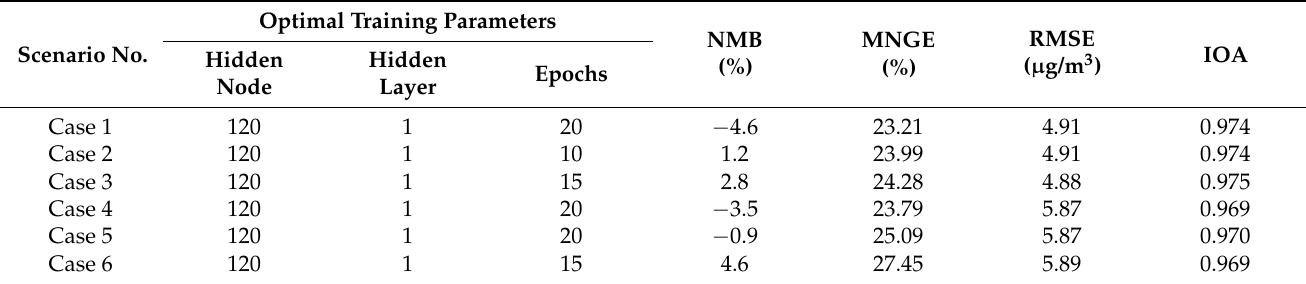
Table 6. Statistical analysis of RNN-LSTM-modeled and AQMS-observed PM 2.5 (Case 1, 4: AQMS + ASOS; Case 2, 5: AQMS + ASOS + all anchored ships; Case 3, 6: AQMS + ASOS + anchored ships over 2000 tons; Case 1~3: North Port; Case 4~6: New